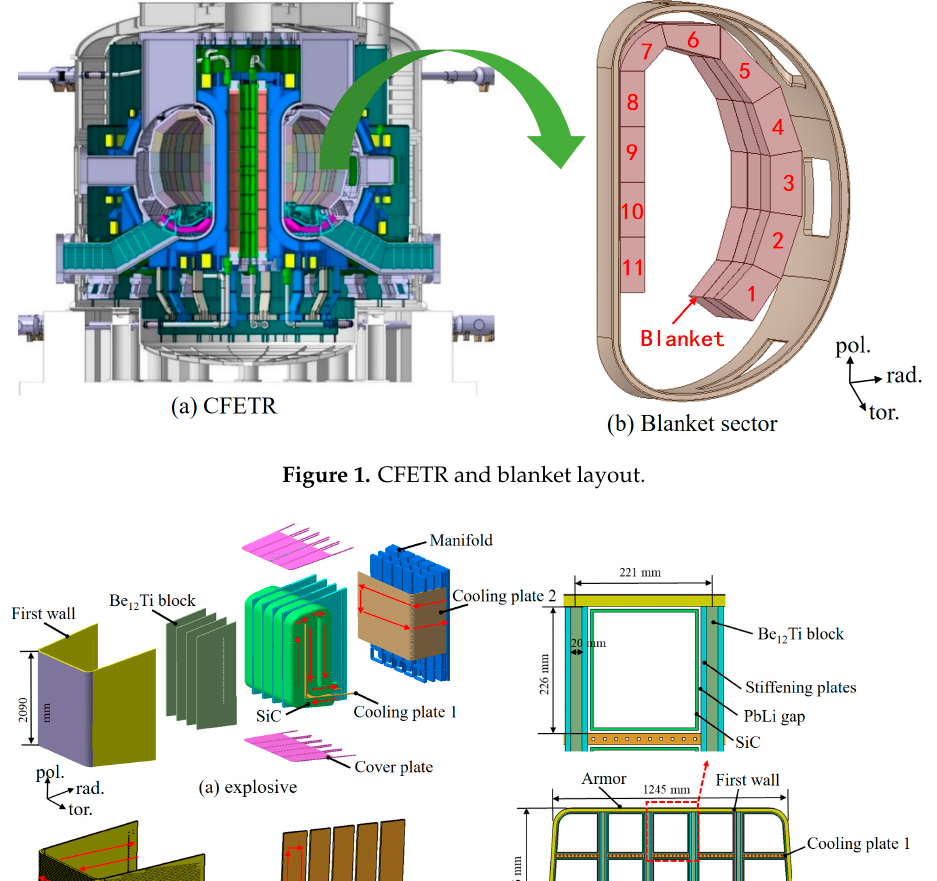
Figure 2. Structural design of the WLLC blanket (module 3#). Table 1. Design criteria for thermal hydraulics.